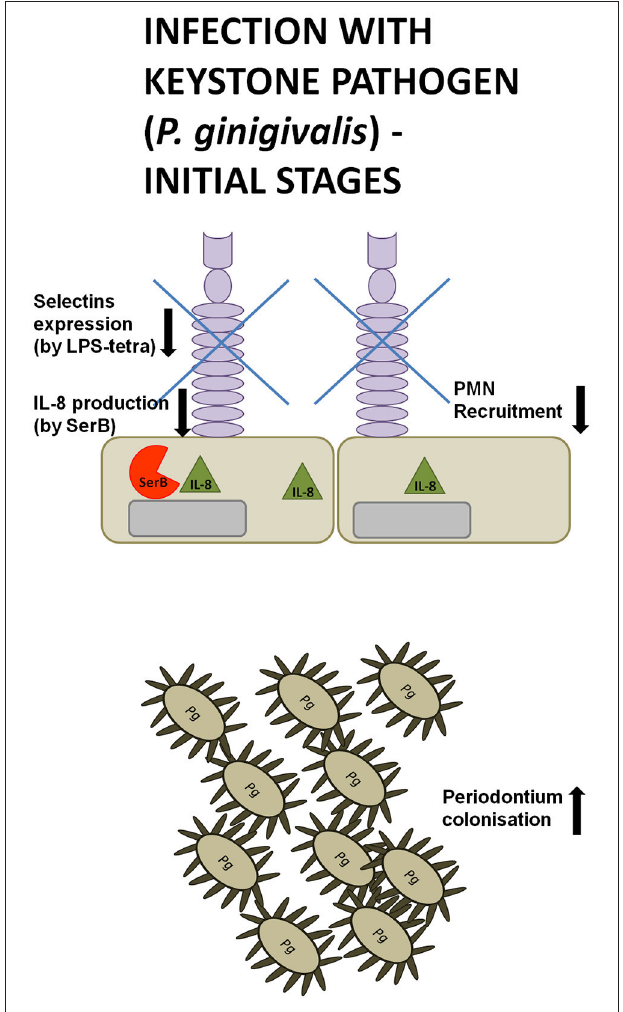
FIGURE 2 | Manipulation strategies of neutrophils and the immune system by P. gingivalis at the initial phase of infection. During the initial phase of an infection with the keystone pathogen P. gingivalis (Pg) secretes serine phosphatase (SerB), inhibiting IL-8 production. At the same time, a tetra-acylated lipid A variant of P. gingivalis LPS suppresses the expression of L- and P-selectins on gingival epithelial cells. These manipulation strategies hinder neutrophil recruitment, giving periodontal pathogens enough time for colonization of periodontal